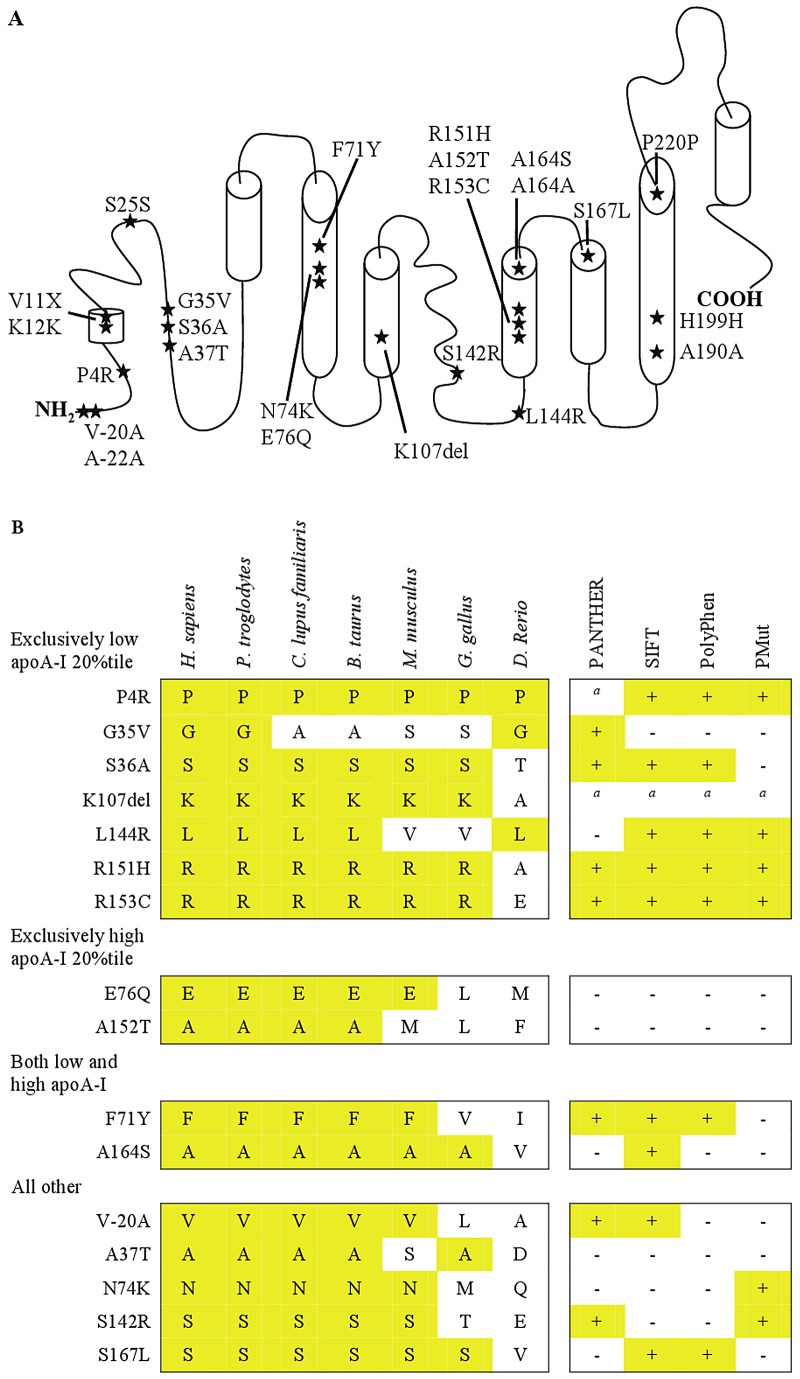
Nonsynonymous and synonymous variants in APOA1.A. The positions of all nonsynonymous and synonymous variants identified by resequencing APOA1 in the Copenhagen City Heart Study (CCHS, n = 10,330) have been superimposed on the secondary structure of apoA-I. B. Evolutionary sequence conservation and predicted functional effects of nonsynonymous genetic variants in APOA1. Variants are divided into four groups, depending on whether they were identified exclusively in the lowest 20 percentile, the highest 20 percentile, or in both the lowest and highest 20 percentiles of the apoA-I distribution, using the extreme phenotype approach. The fourth group includes variants exclusively identified using the population-based resequencing approach. The truncation, APOA1 V11X, is not included in the figure. The alignment includes human (H. sapiens), chimpanzee (P. troglodytes), dog (C. lupus familiaris), cow (B. taurus), mouse (M. musculus), chicken (G. gallus), and zebrafish (D. Rerio). Alignment by HomoloGene (www.ncbi.nlm.nih.gov/homologene/). anot possible to model. PANTHER: + = P-deleterious>0.5; − = P-deleterious<0.5 (www.pantherdb.org/). SIFT: + = affect protein function; − = tolerated (http://sift.jcvi.org/). PolyPhen: + = probably or possibly damaging; − = benign (http://genetics.bwh.harvard.edu/pph2/). PMut: + = pathological; − = neutral (http://mmb2.pcb.ub.es:8080/PMut/). Figure 7A was adapted from [6].